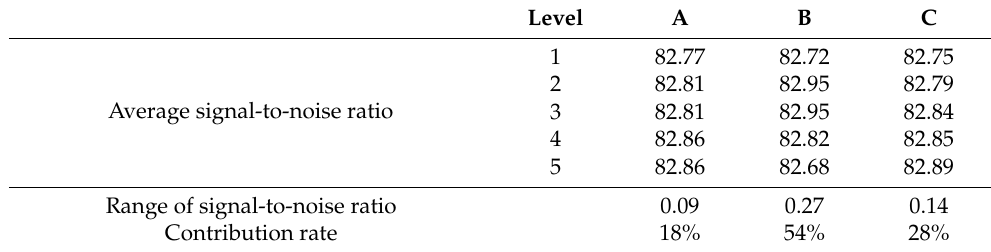
Table 5. Current density treatment results.